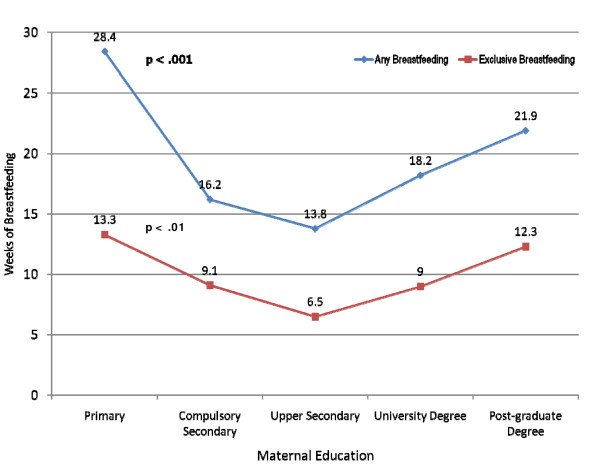
Weeks of any and exclusive breastfeeding by level of maternal education. Compulsory Secondary is Form 3 and Upper Secondary is Form 7. Participants lost-to-follow-up (n = 33) were excluded. The sample size for this analysis was 1284.